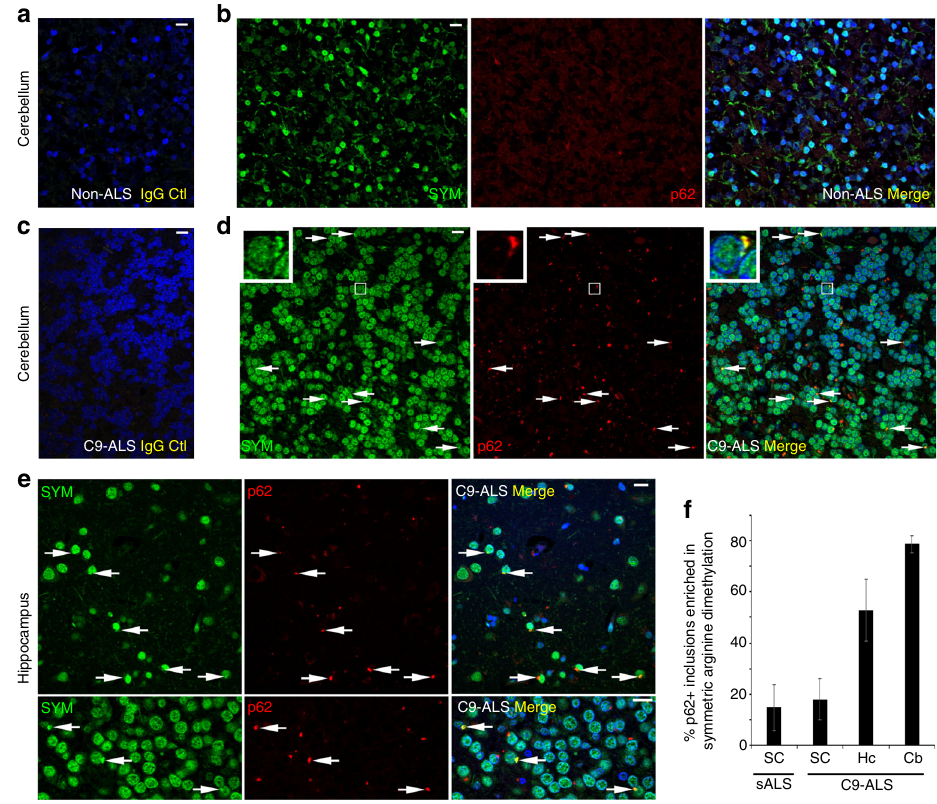
Fig. 6 Patients with C9ROF72 repeat expansions exhibit inclusions rich in symmetrically arginine-dimethylated proteins. a , b Immuno fl uorescent microscopy of non-ALS human cerebellum labeled with ( a ) control non-speci fi c antibodies or ( b ) antibodies speci fi c for p62 and